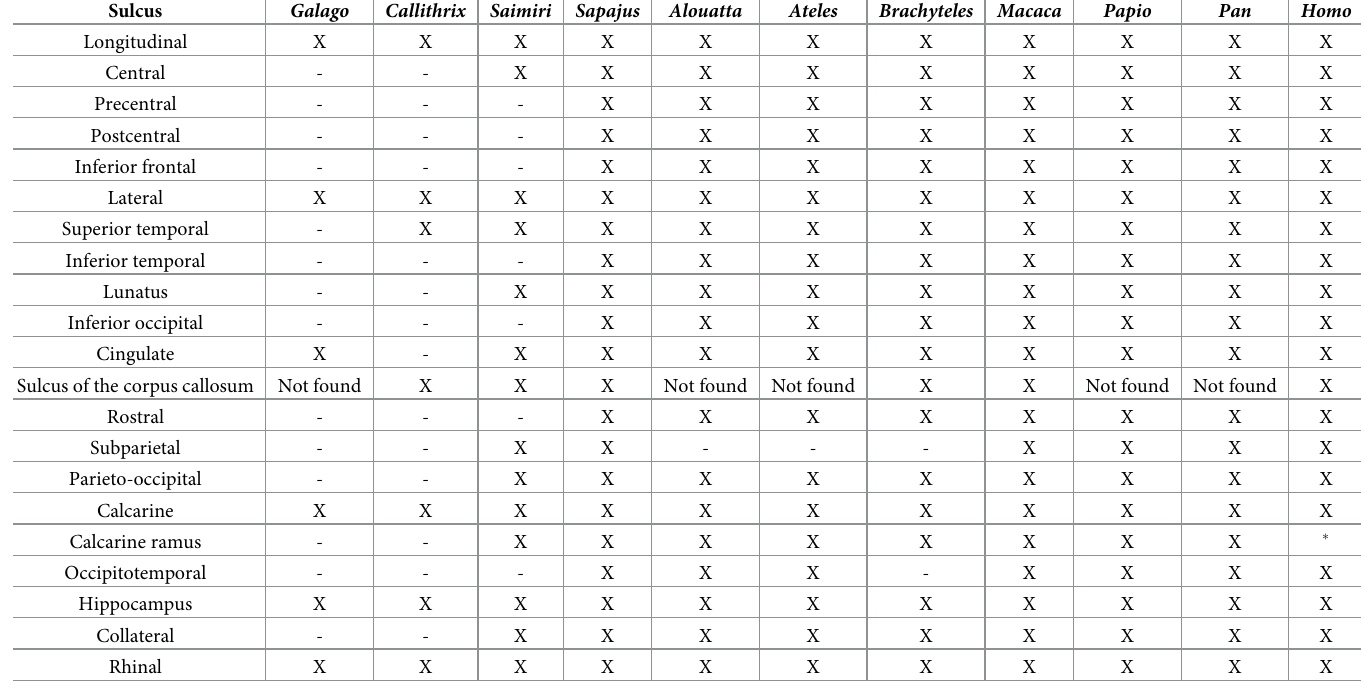
Table 1. Presence of the main sulci in the medial region of the brain of modern humans and other primates, in special those belonging to the genera Pan , Papio , Macaca , Galago , Ateles , Cebus , and Sapajus